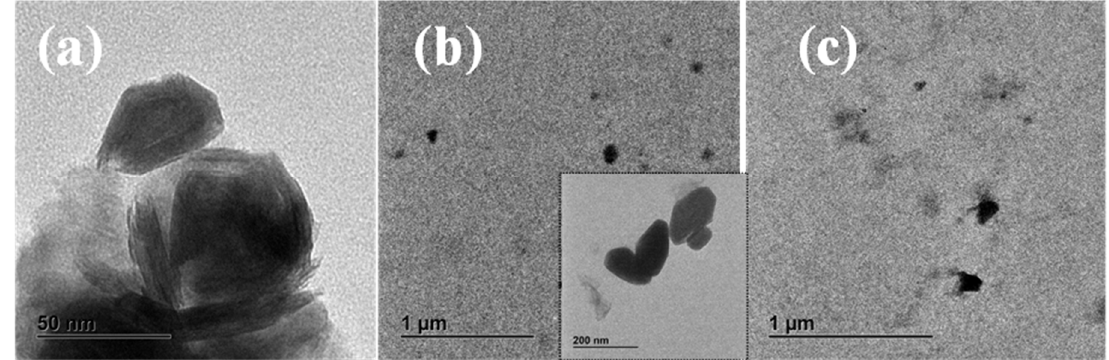
Figure 1. TEM micrographs for ( a ) neat IF-WS 2 nanoparticles, ( b ) PLLA/IF-WS 2 (0.1 wt%) and ( c ) PLLA/IF-WS 2 (1.0 wt%) nanocomposites.